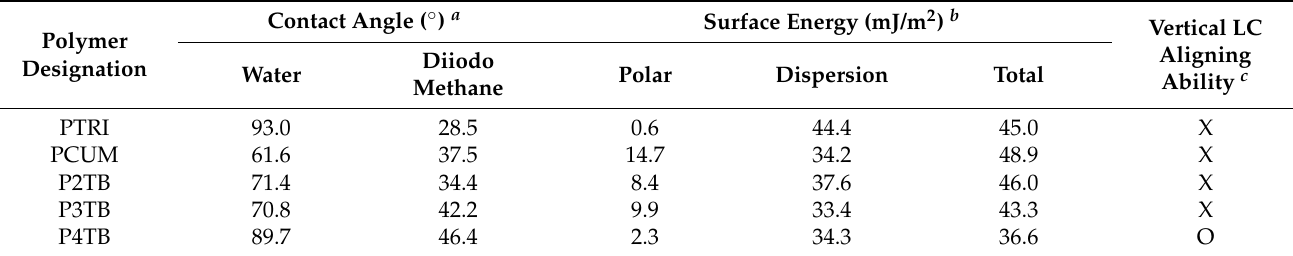
Table 1. Surface energy values and LC alignment properties.